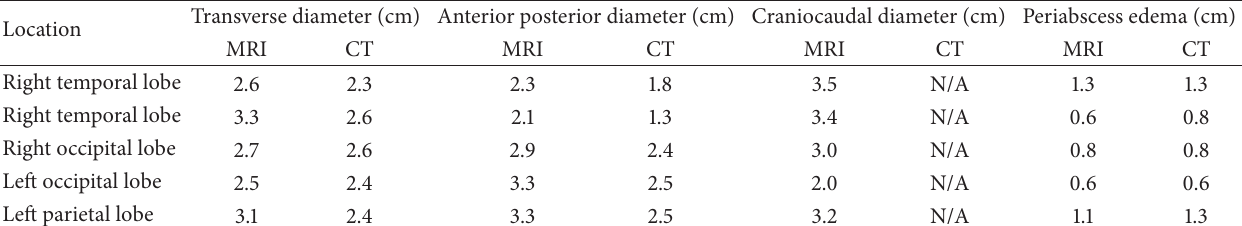
Table 2: Brain abscesses by MRI and CT with IV contrast done on the same date.